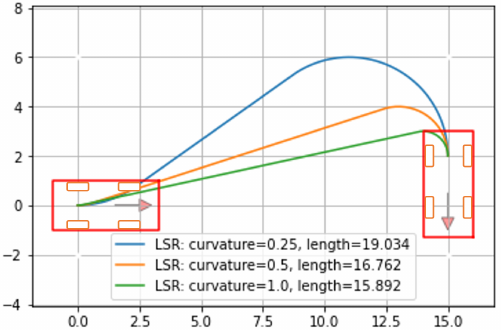
Figure 3. Reed-Shepp paths with different curvature